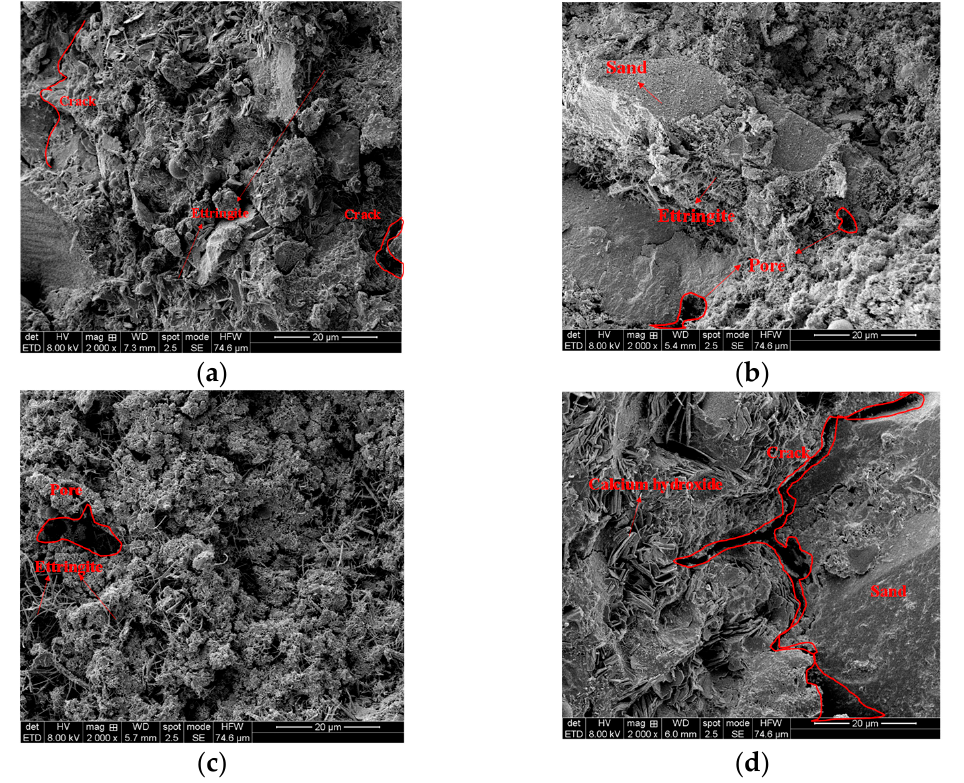
Figure 4. Variation pattern of microstructure versus distance for each test point. ( a ) 0.15 m; ( b ) 0.45 m; ( c ) 0.75 m; ( d ) 1.05 m.